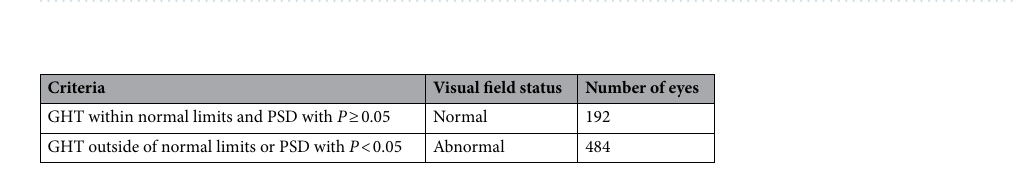
Table 2. Eyes with and without visual field damage.